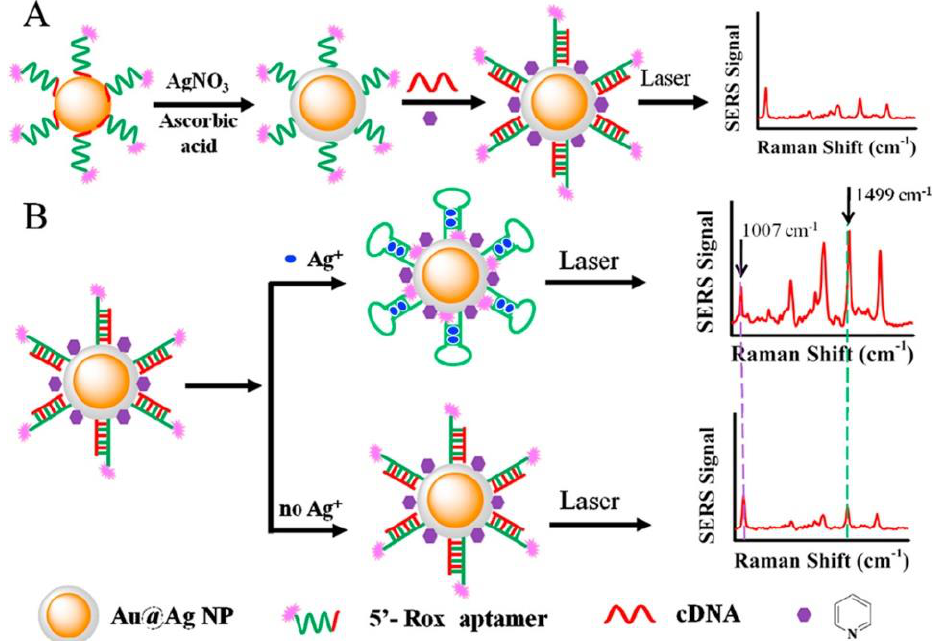
Figure 17. Schematic representation of Ag + detection with ratiometric SERS aptasensor. ( A ) nanoparticles Ag core-shell preparation; ( B ) Ag ion detection. Adapted with permission from Wu et al. [76] (Copyright © (2018) Elsevier.